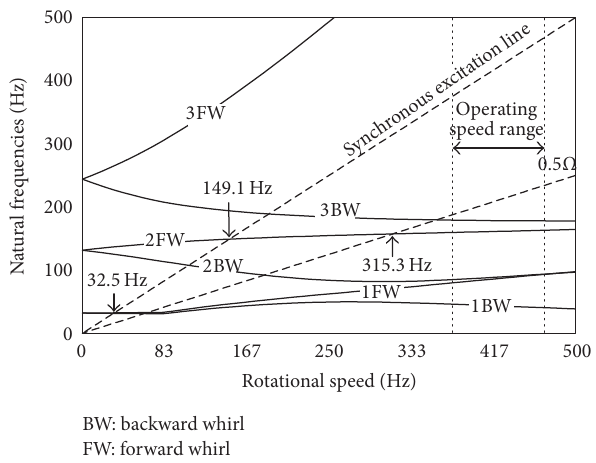
Figure 7: Campbell diagram for the radial clearance of the squeeze film damper equal to 0.1905